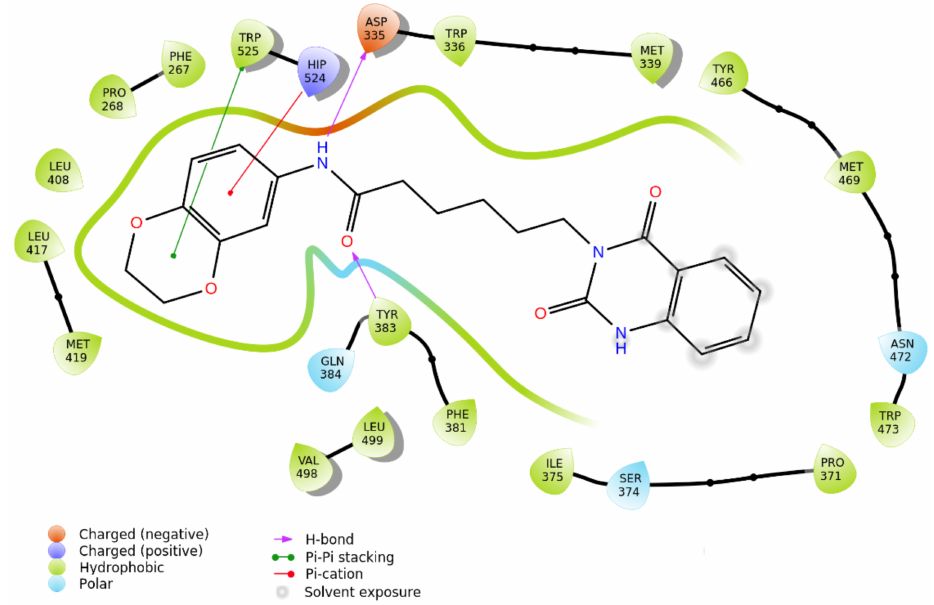
Figure 10. 2D interaction panel related to the selected docking pose of compound 4 against